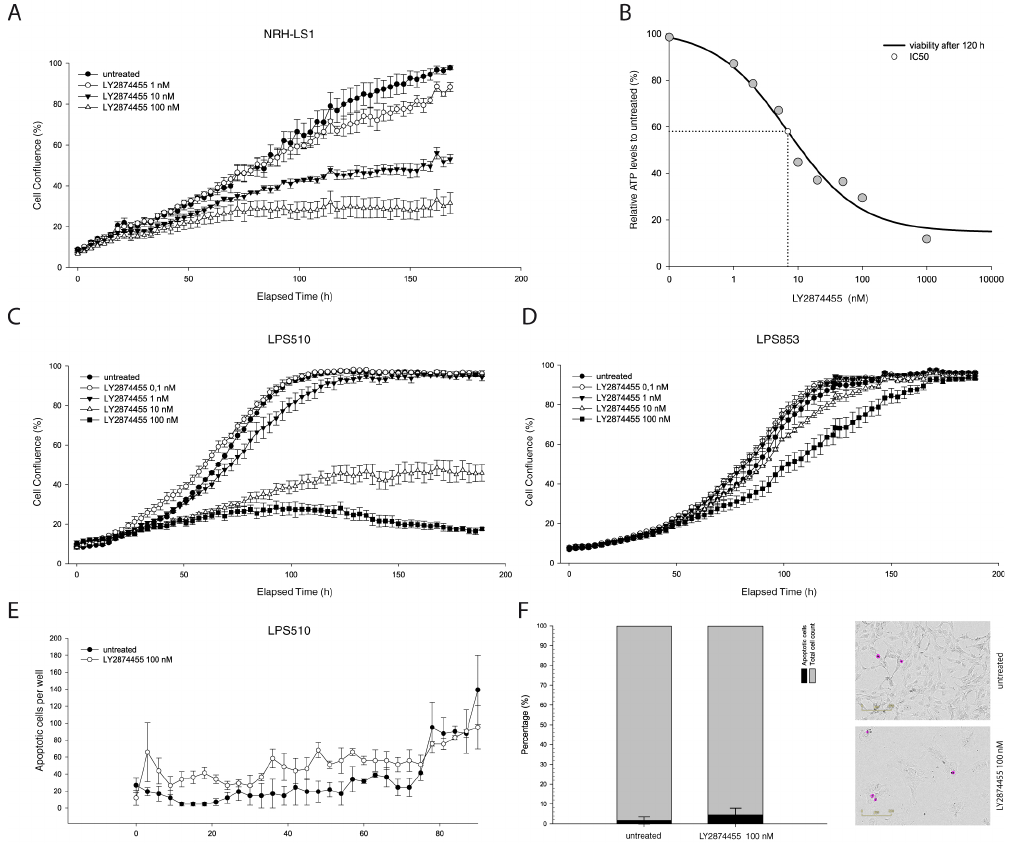
Figure 2. The effect of LY2874455 on the proliferation and viability of NRH-LS1, LPS510 and LPS853 cells. ( A ) Proliferation of NRH-LS1 cells at different concentrations of LY2874455; one representative experiment is shown ( n = 3), error bars represent the standard error of the mean (SEM) of technical replicates; ( B ) The IC50 was estimated at 7 nM based on NRH-LS1 cell viability after 120 h of treatment with LY2874455; Proliferation of LPS510 ( C ) and LPS853 ( D ) cells in the presence of LY2874455. ( E ) The number of LPS510 cells with active caspase 3/7 during 96 h of treatment with 100 nM of LY2874455; ( C – E ) One representative experiment is shown ( n = 3), error bars represent the standard error of the mean (SEM) of technical replicates; ( F ) The percentage of apoptotic LPS510 cells after 96 h of treatment with 100 nM of LY2874455. The mean of experiments is shown ( n = 4), error bars represent the standard deviation (SD) of the experiments. Representative images show apoptotic cells outlined in purple based on measured apoptotic signal. For all experiments untreated is with DMSO concentration corresponding to that of the highest drug